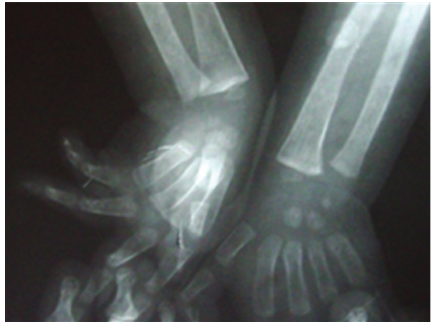
Figure 4: Showing wrist X-ray with features of healing